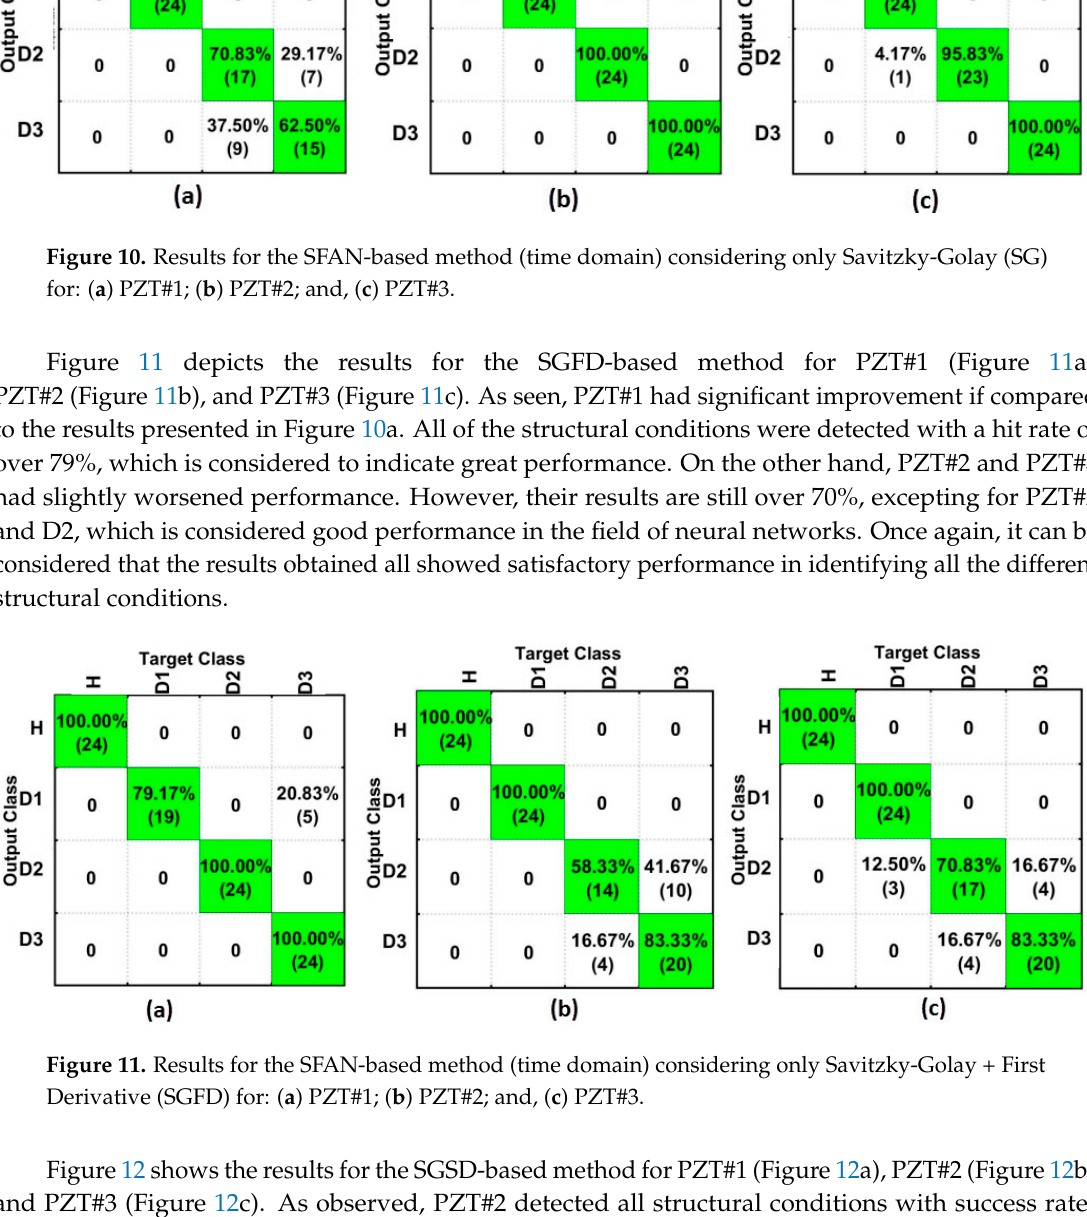
Figure 12. Results for the SFAN-based method (time domain) considering only Savitzky-Golay + Second Derivative (SGSD) for: ( a ) PZT#1; ( b ) PZT#2; and, ( c ) PZT#3. Finally, Figure 13 shows a comparison between the best results for the analysis in the frequency domain (top) and time domain (bottom), considering only the SFAN-based method for PZT#1 (Figure 13a), PZT#2 (Figure 13b) and PZT#3 (Figure 13c). As observed, PZT#2 and PZT#3 had substantial improvement in the time domain analysis, with a hit rate of over 90% for the best analyzed case (D1). Furthermore, PZT#1 detected H and D1 structural conditions with success rates of 100% when considering the time domain analysis. On the other hand, PZT#1 had better performance for the frequency domain-based method when considering the damage in D2 and D3. Interestingly, the analysis conducted in the time domain has shown an improved accuracy of SFAN-based methods (Figure 13). This result is consistent with those in reference [35]. It is important to highlight that the damage detection in the time domain was carried out without considering the Frequency Response Function (FRF) or inverse Laplace/Fourier Transform, which by itself is a great advantage in terms of computational efforts. It simplifies and speeds up the damage detection in real applications.